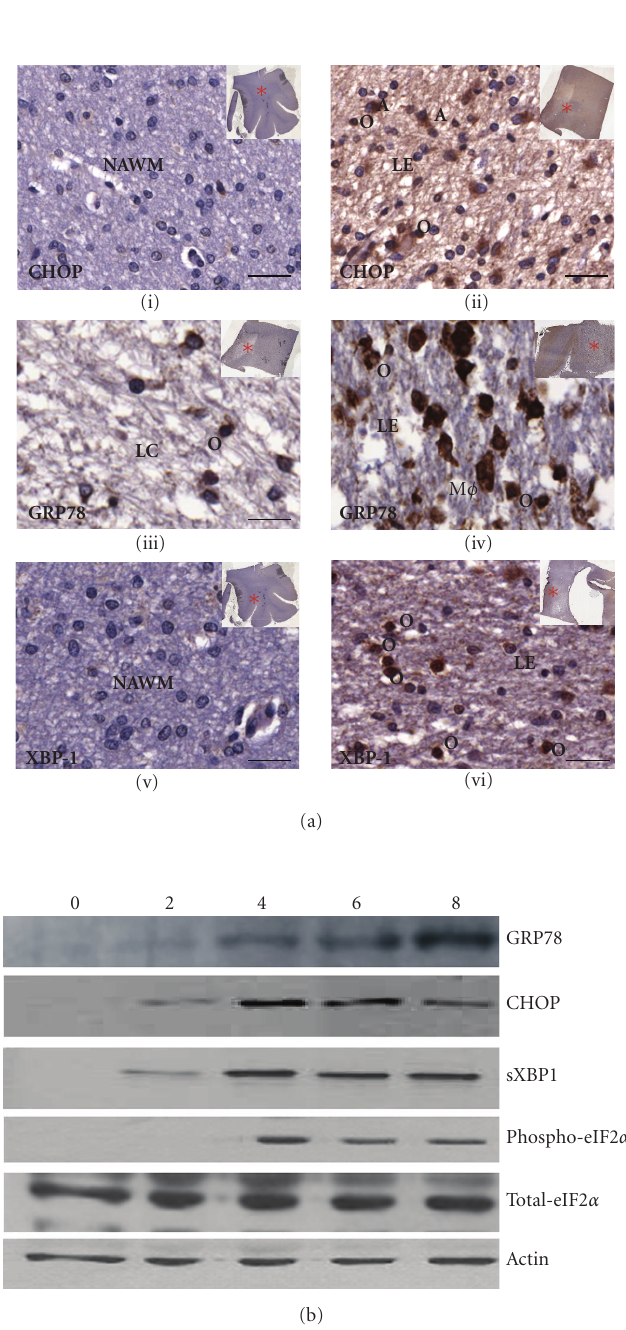
Figure 2: Detection of protein levels of UPR target genes. (a) Immunohistochemical detection of CHOP, GRP78, and XBP1 in Multiple Sclerosis patient postmortem brain tissue. Representative images showing upregulation of CHOP (ii) at the edge (LE) of a chronic active lesion, in comparison to (i) NAWM. GRP78 expression was downregulated in the center of a chronic active lesion (iii) when compared to the edge (iv) of actively demyelinating lesions. Sample images illustrate the variety of morphologically distinct cell types that express CHOP or GRP78 including macrophages (Mø), astrocytes (a), and oligodendrocytes (o). Increased expression of XBP1 was found at the edge of a chronic active lesion (vi), when compared to normal-appearing white matter (v). XBP1 immunostaining is also apparent in a large number of oligodendrocytes (o). All immunoperoxidase-stained cells were detected using the chromogen, DAB (brown), and counterstained with hematoxylin for nuclei (blue). Scale bars = 250 μ m. Letter codes are as follows: NAWM = normal-appearing white matter; LC = lesion center; LE = lesion edge. Red astrices indicate location of lesion within brain sections analyzed. (b) PC12 cells were treated with 0.25 μ M of Tg for 0, 2, 4, 6, and 8 hours. Whole cell lysates were analyzed by Western Blot for GRP78, CHOP, spliced XBP1, phospho-eIF-2 α , and total- eIF-2 α . β -Actin was used to determine equal loading of